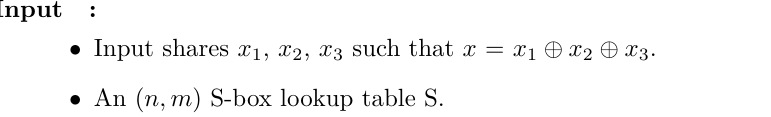
Algorithm 3: Second-order secure masked S-box with pre-processing for arbi- trary